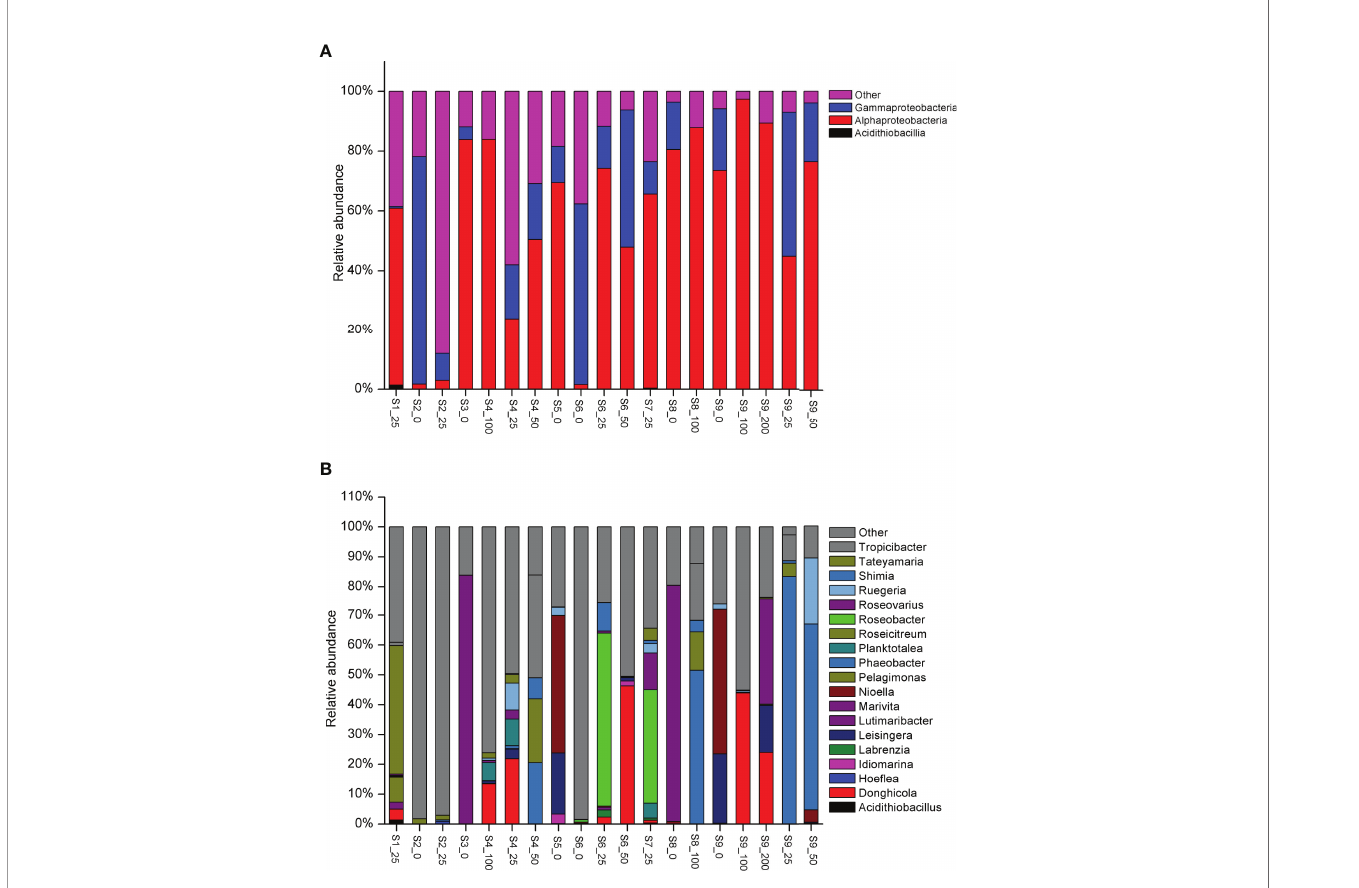
FIGURE 3 | Taxonomic distribution of samples through High-throughput sequencing analysis in class level (A) and genus level (B)